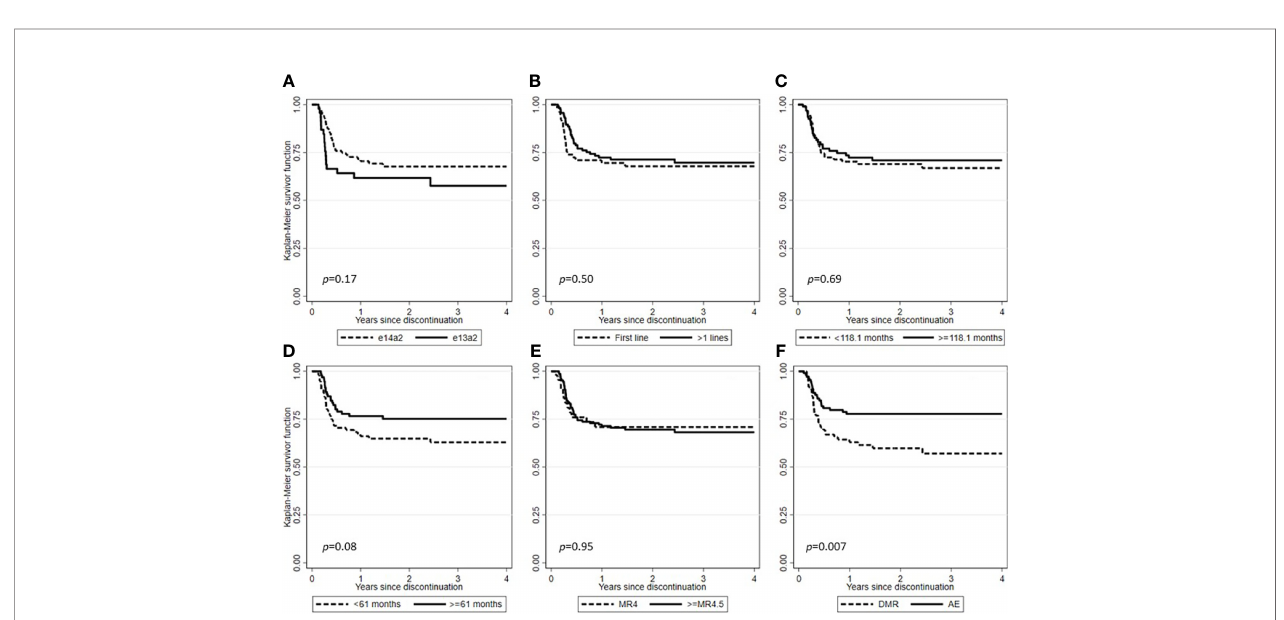
FIGURE 3 | Treatment-free remission (TFR) after tyrosine kinase inhibitor (TKI) therapy (Kaplan-Meier estimate). (A) TFR according to BCR-ABL1 transcript type. (B) TFR according to lines of therapy. (C) TFR according to median duration of TKIs therapy. (D) TFR according to median duration of DMR. (E) TFR according to the degree of DMR. (F) TFR according to the main reasons for TKIs dose